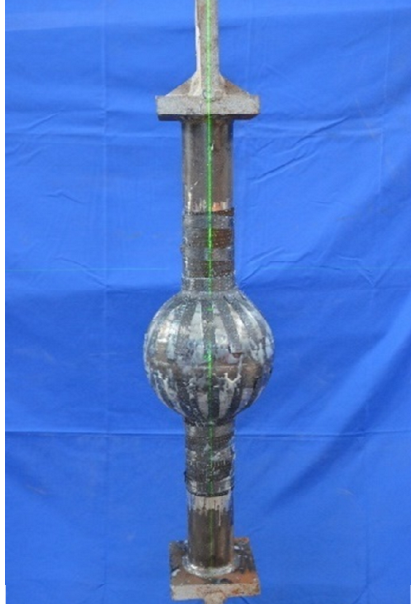
Figure 9. Specimen bonded with CFRP.